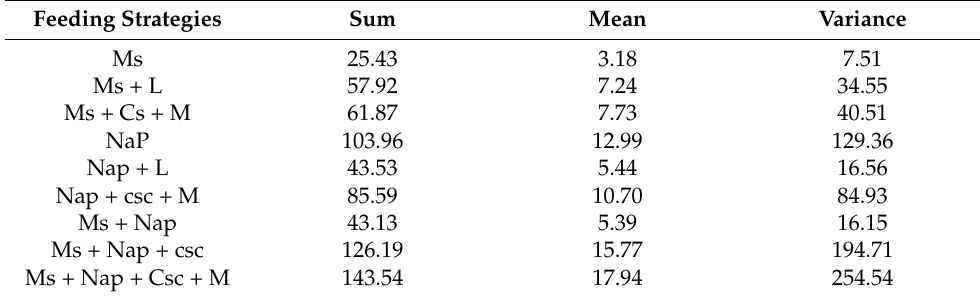
Table 5. Interplay of weather variability and price risks in dairy feeding strategies. Feeding